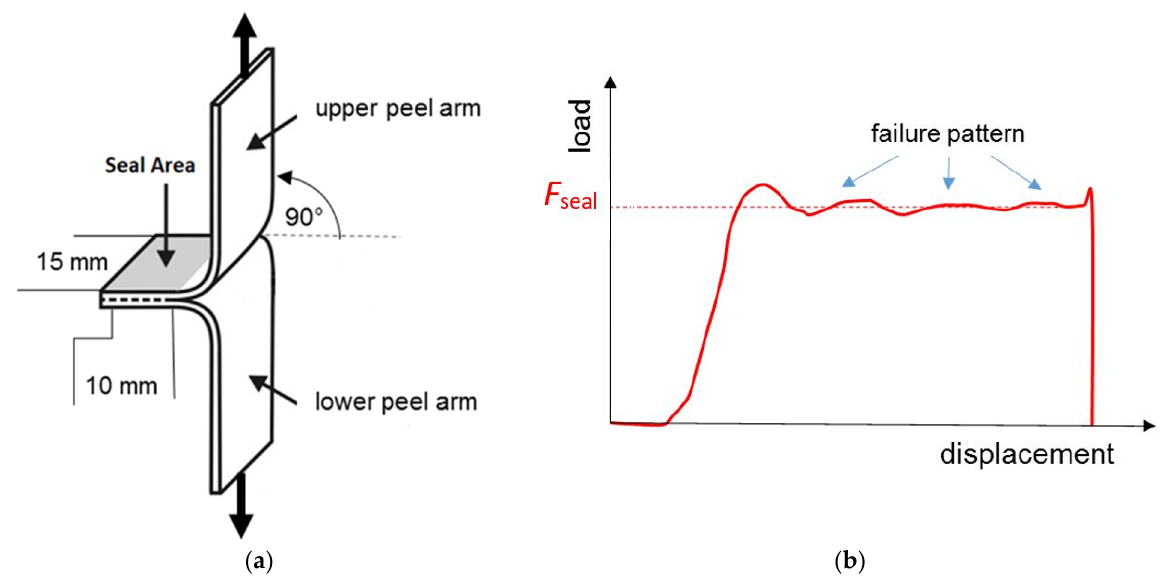
Figure 1. T-test sample for seal strength measurements ( a ). DIN 55529 and scheme of a load displacement curve with determination of a seal strength ( b ).